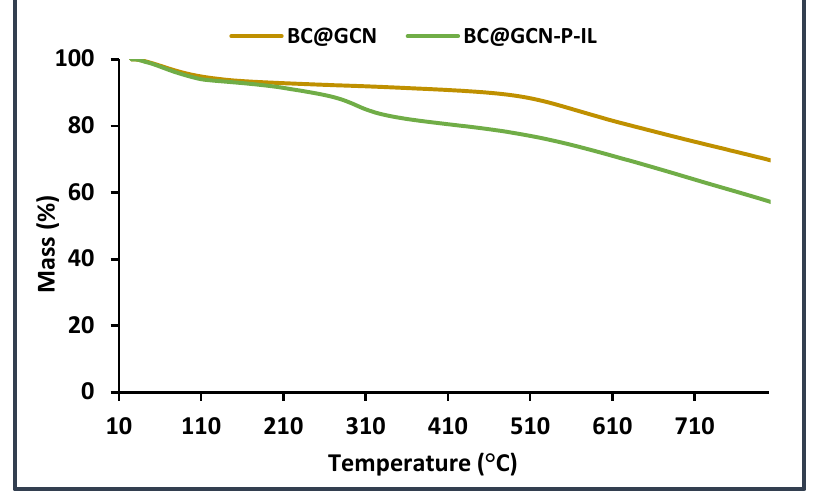
Figure 5. Thermograms of BC@GCN and BC@GCN-P-IL.